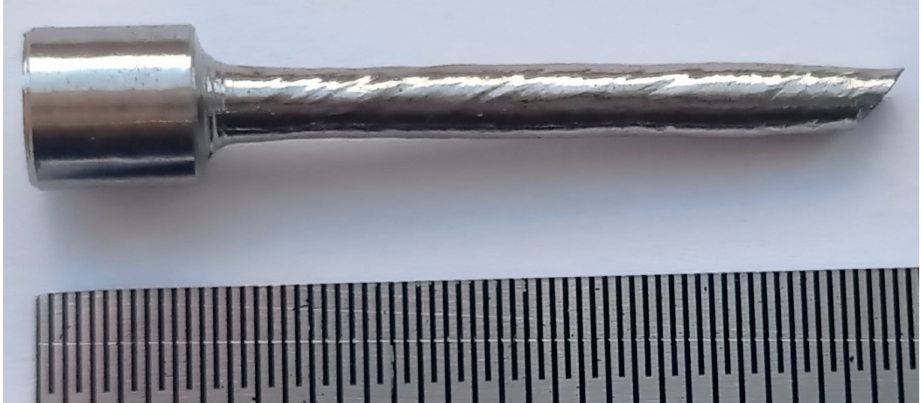
Figure 6. Deformation bands on the surface of the tensile specimen of the TWIP steel subjected to 1 ECAP pass in front of a ruler with 1 mm